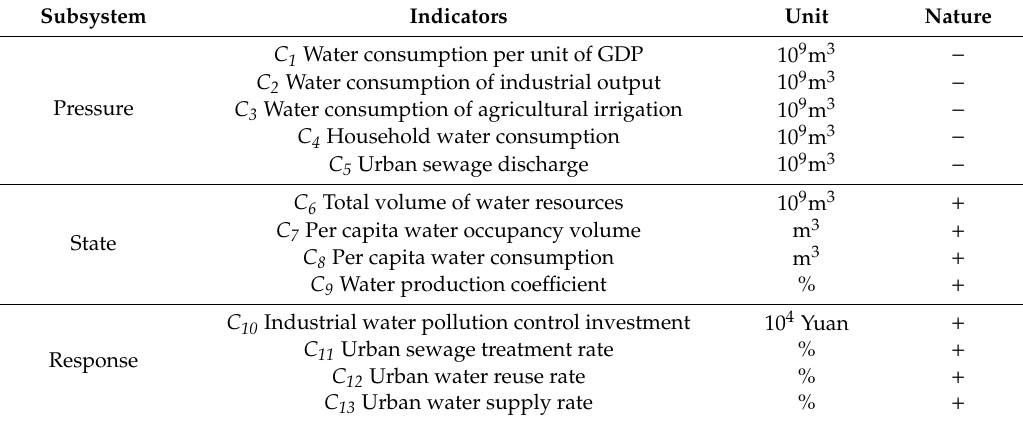
Table 2. Indicator system for the water